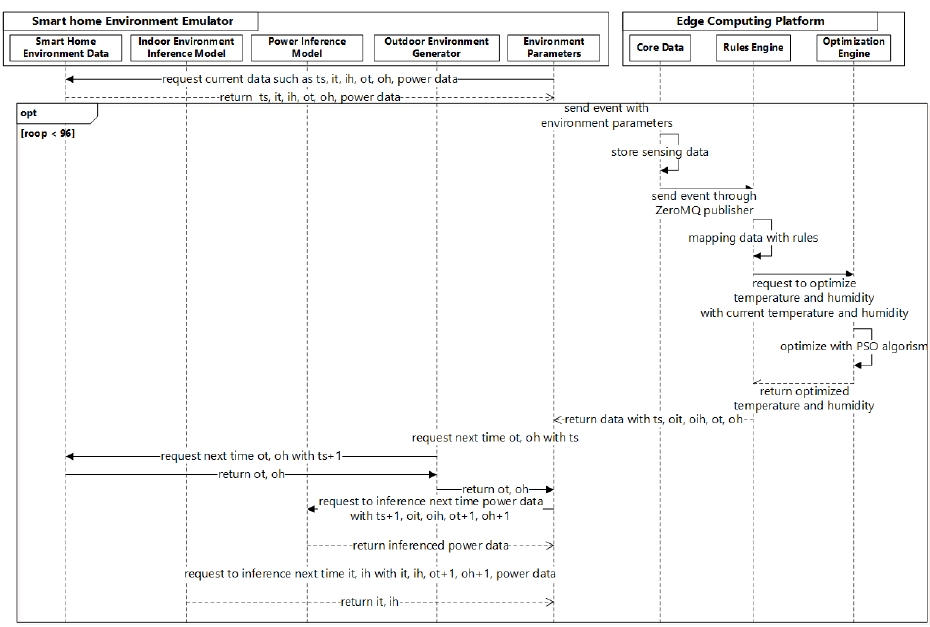
Figure 4. Sequence Diagram of Proposed System Operation for Efficient Thermal Comfort.